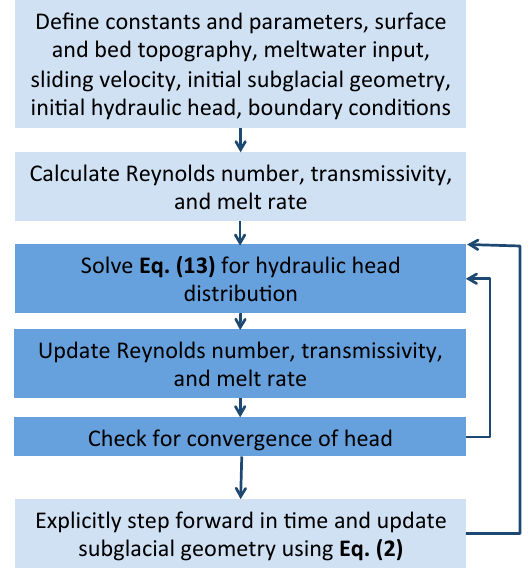
Figure 1. Schematic of the computational procedure used to solve the model